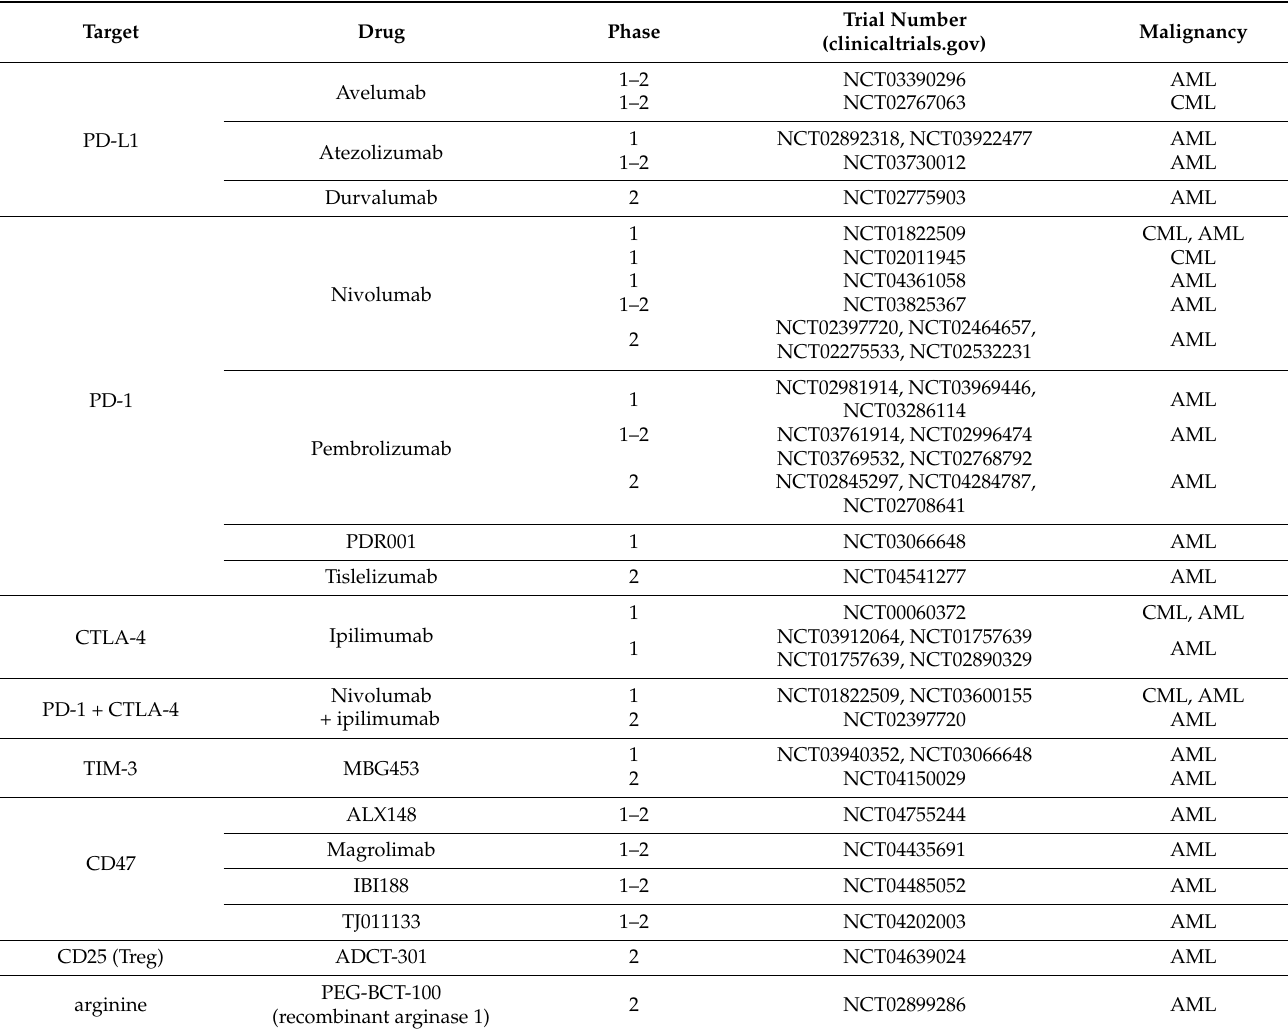
Table 2. Clinical trials of drugs and treatments that target immunosuppressive factors (either as monotherapy or in combination) in chronic and acute myeloid leukemia, either ongoing or completed trials, according to clinicaltrials.gov database